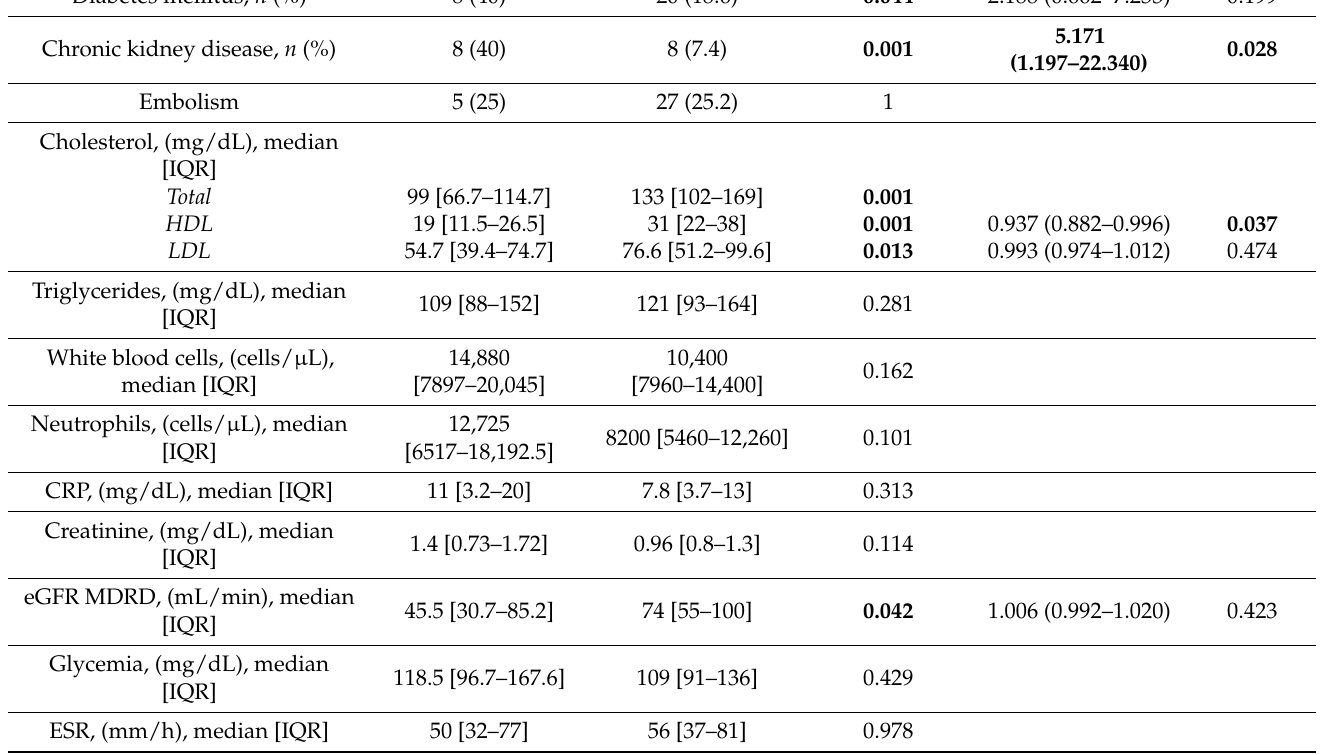
Table 2. Univariable and multivariable analysis of factors possibly associated with IE outcome. Outcome of Hospitalization Univariable Analysis